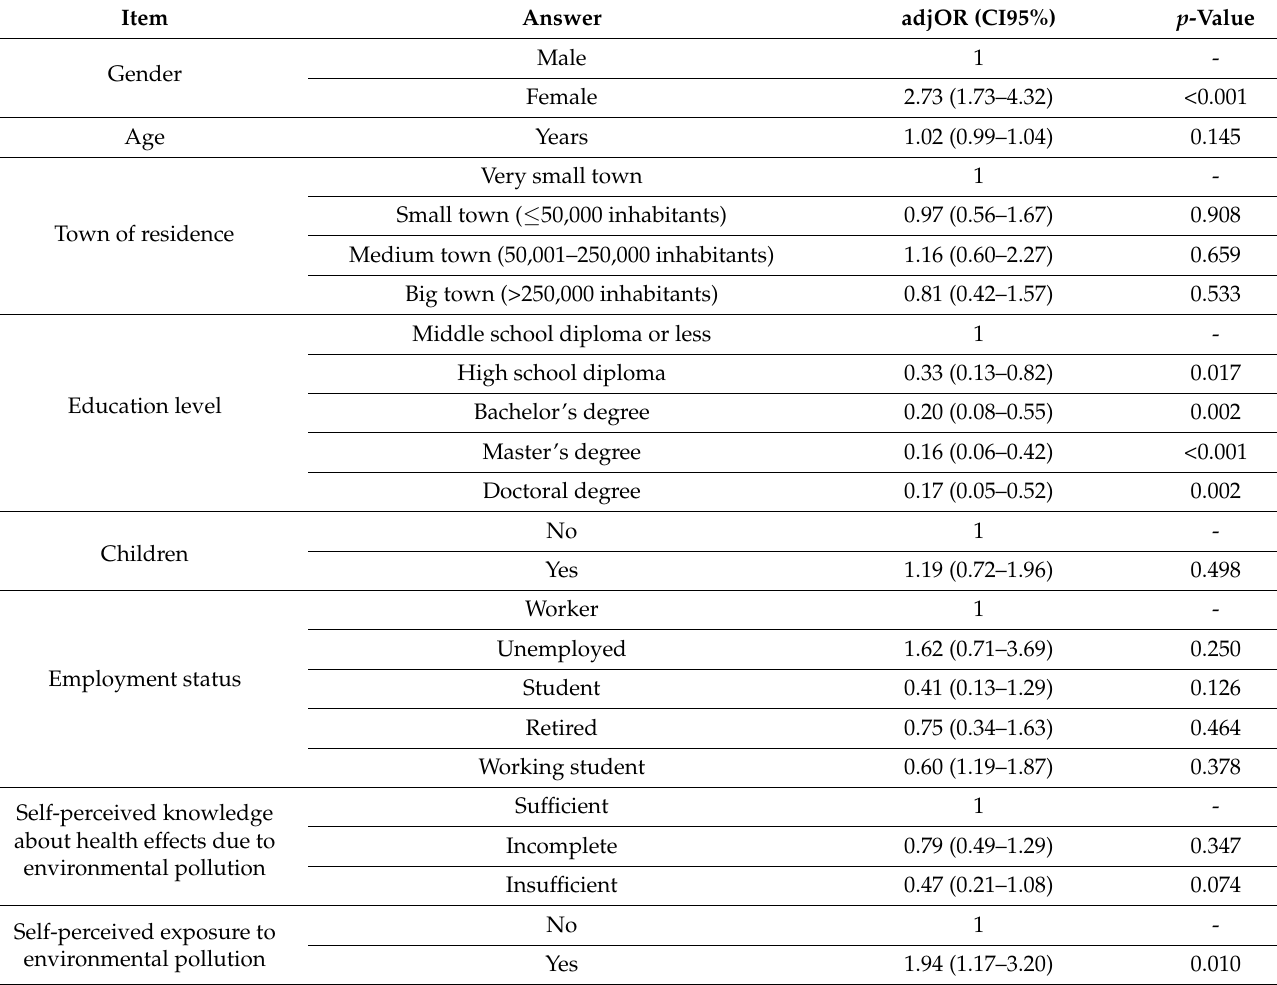
Table 3. Multivariable logistic regression model on the third outcome: estimation of burden of disease from environmental